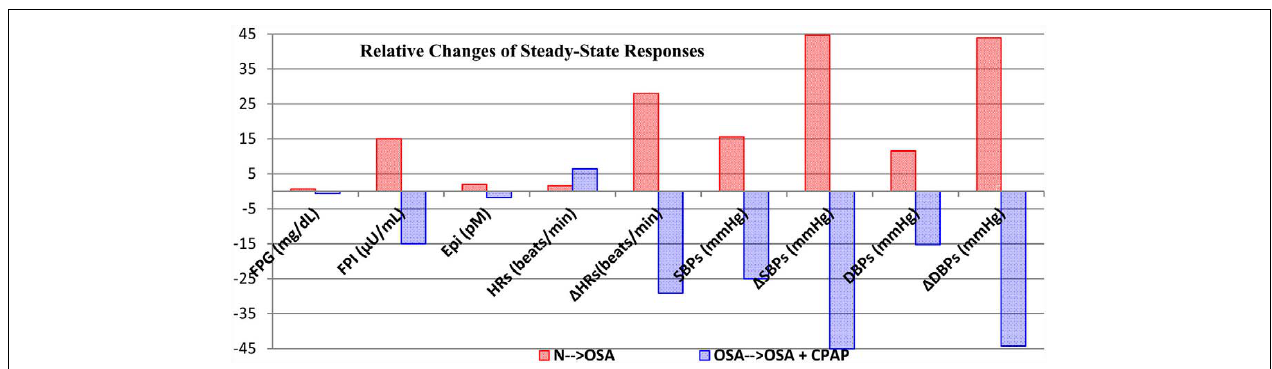
FPI, fasting plasma insulin; Epi, arterial epinephrine concentration. Δ HR, Δ SBP, and Δ DBP correspond to maximum amplitude of fluctuation in heart rate (beats/min), maximum amplitude of fluctuation in systolic blood pressure (mmHg), and maximum amplitude of fluctuation in diastolic blood pressure (mmHg), respectively. Subscript “s” represents sleep.